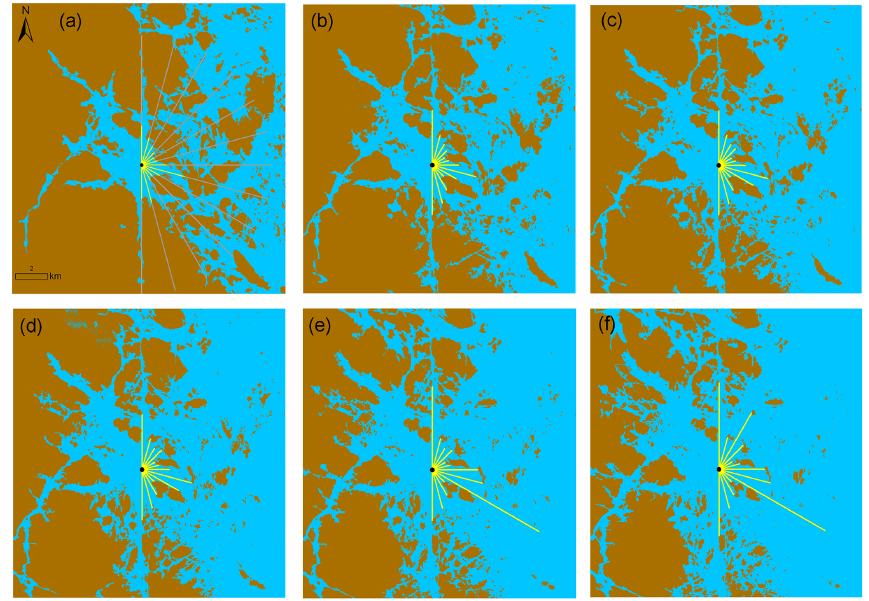
Figure 4. Illustrations showing the variations in seaward radial lines intercepted with land over the last 5.4ky: (a) 0.1calkaBP, (b) 2.5calkaBP, (c) 3.5calkaBP, (d) 4calkaBP, (e) 4.5calkaBP, and (f)